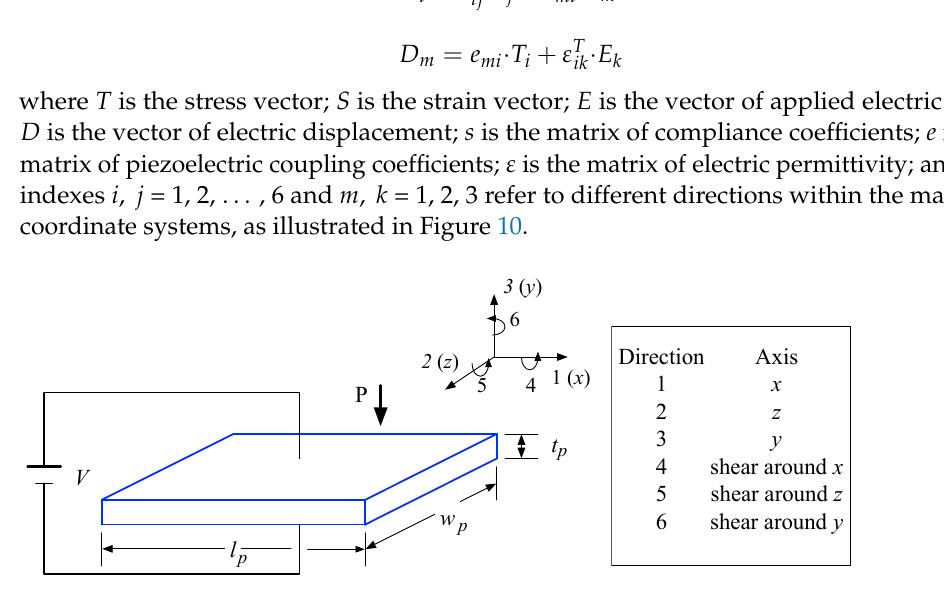
Figure 10. Axis nomenclature for the piezoelectric constitutive equation.